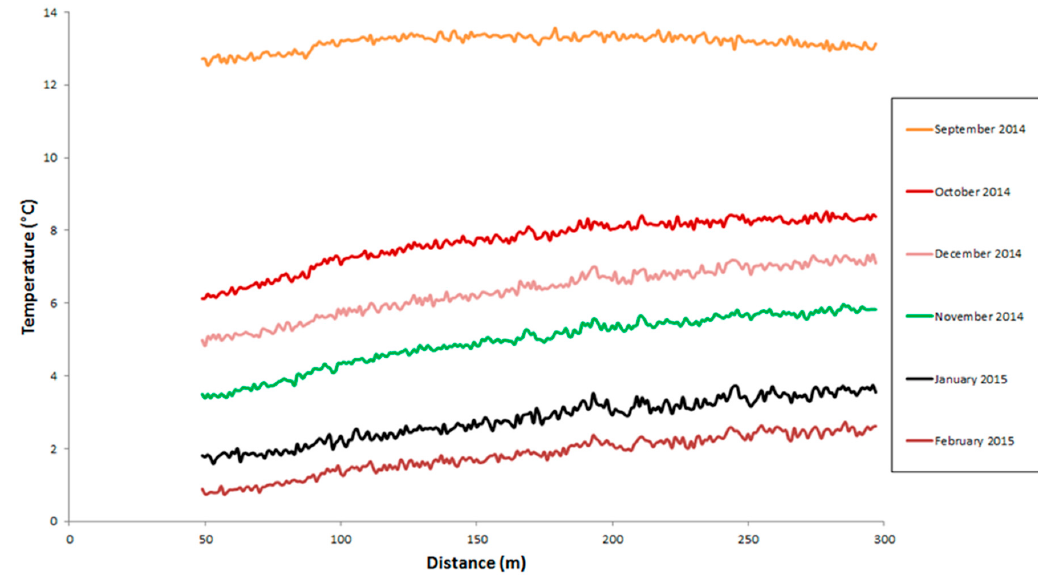
Figure 8. Seabed sediment temperatures measured from September 2014 to February 2015 in Liito-oravankatu.